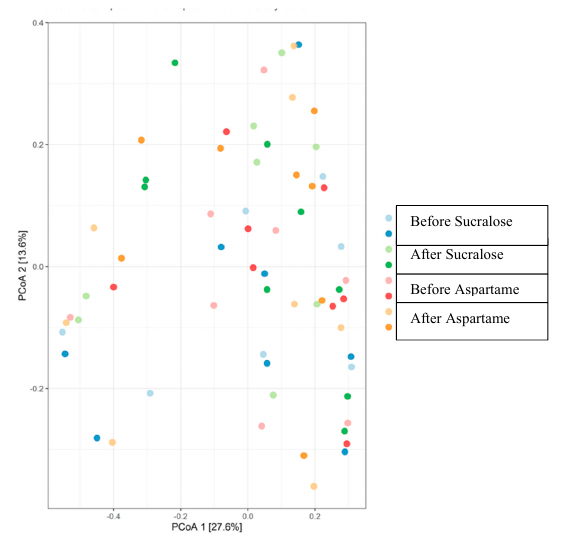
Figure 4. Principal coordinates analysis of the microbiota community structure (unweighted UniFrac distance) before and after treatment with sucralose or aspartame; statistical comparison by permutational multivariate analysis of variance (PERMANOVA) with 500 permutations. ( n = 17). Table 5. PERMANOVA 1 analysis of different factors with the unweighted UniFrac distance matrix. Adonis Model 1 R 2